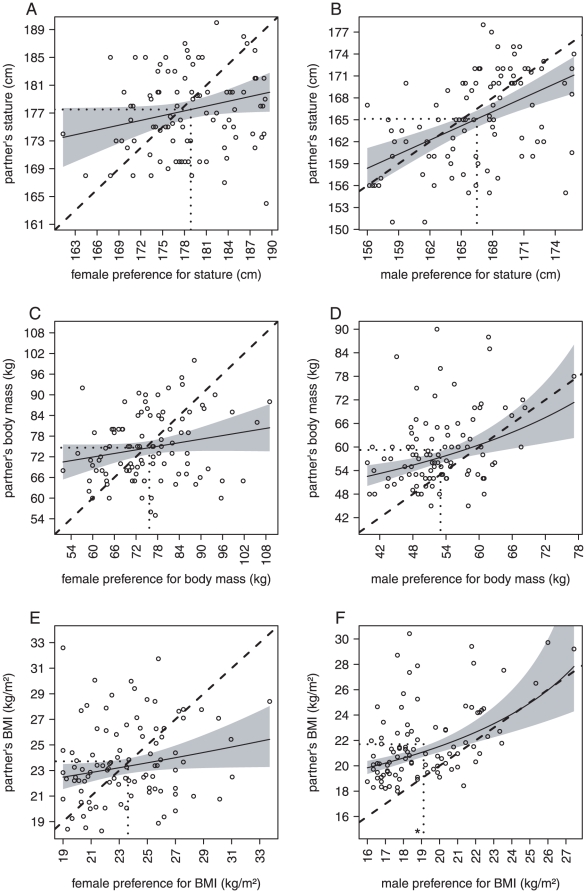
Plots of regression models between preferred and actual partner's characteristics.Plots of models concerning females and males subjects are presented on the left and on the right, respectively. The first row represents plots of models for stature, the second row for body mass, and the last for BMI (considering only indirect preferences, see text for details). Grey shaded area represents 95% confidence interval of the regression lines. Dashed straight lines represent perpendicular bisectors (y = x). Dotted lines represent mean values. Data of the models represented in plots D, E and F have been transformed using Box-Cox transformations to reach linear model assumptions. The star label in the plot F represents data of an outlier not considered in the statistical analysis.